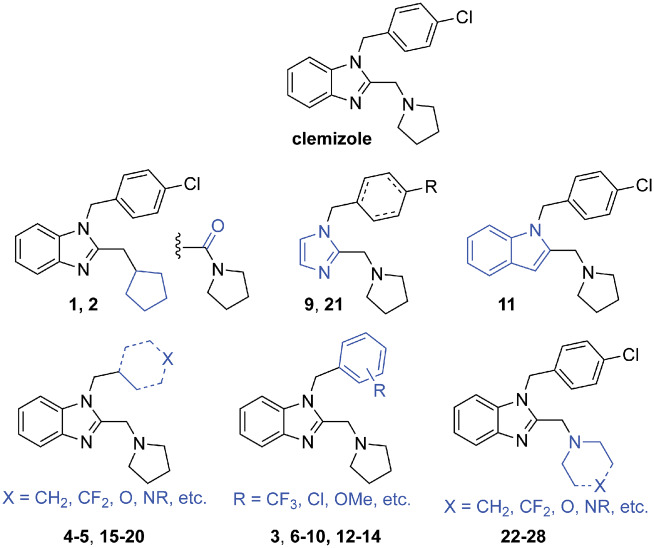

Structure of clemizole and clemalogues 1–28. Chemical structure of clemizole and 28 clemizole analogues synthesized as part of SAR studies detailed herein. Sites of modification to the clemizole structure are highlighted in blue for each clemalogue subtype shown. Full chemical structures are provided in Supplementary Table S1.